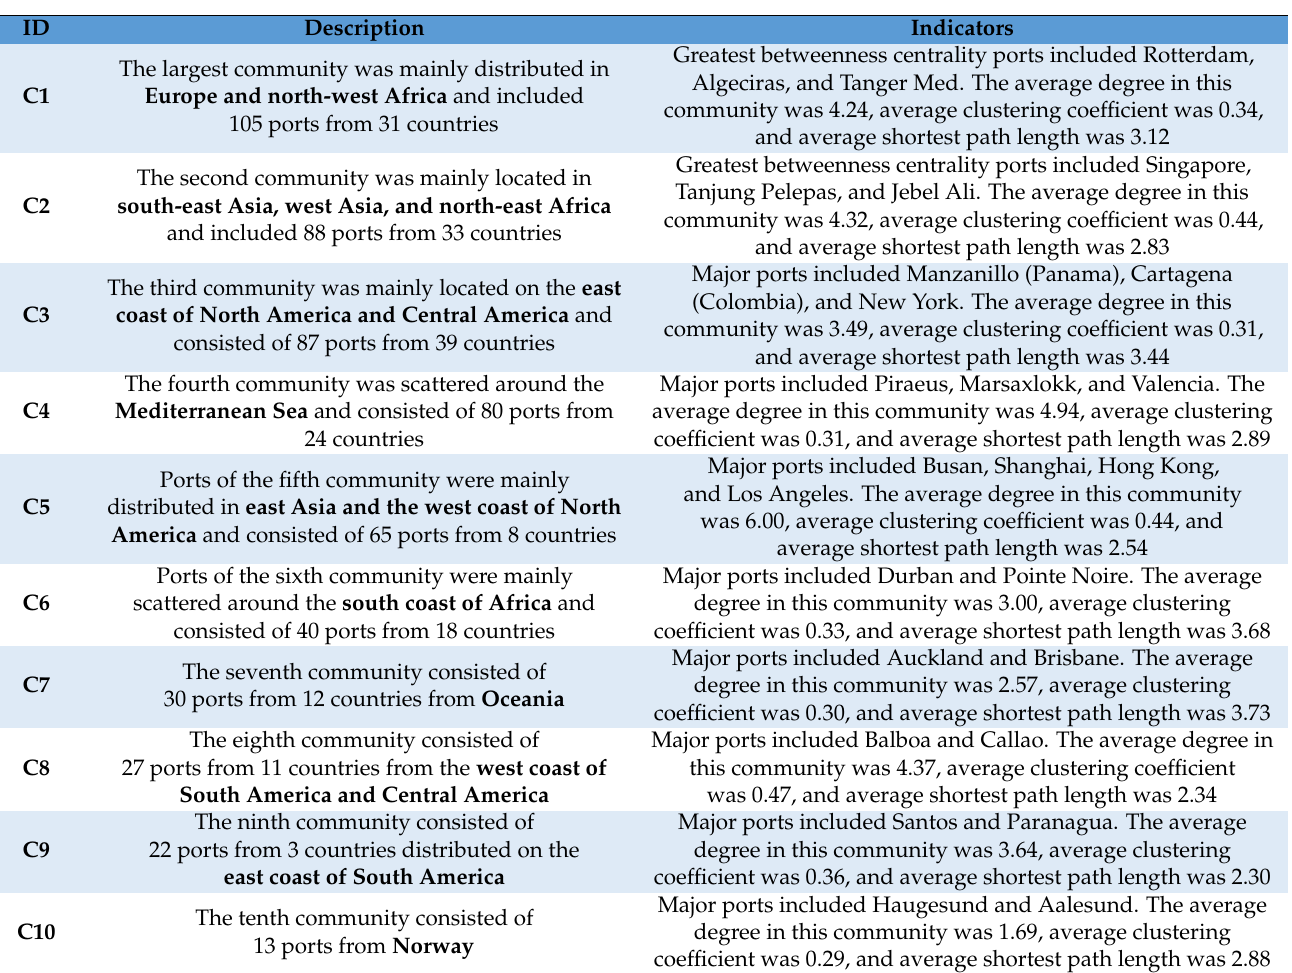
Table 5. Description and indicators of the 10 communities determined from the GLSN analysis.